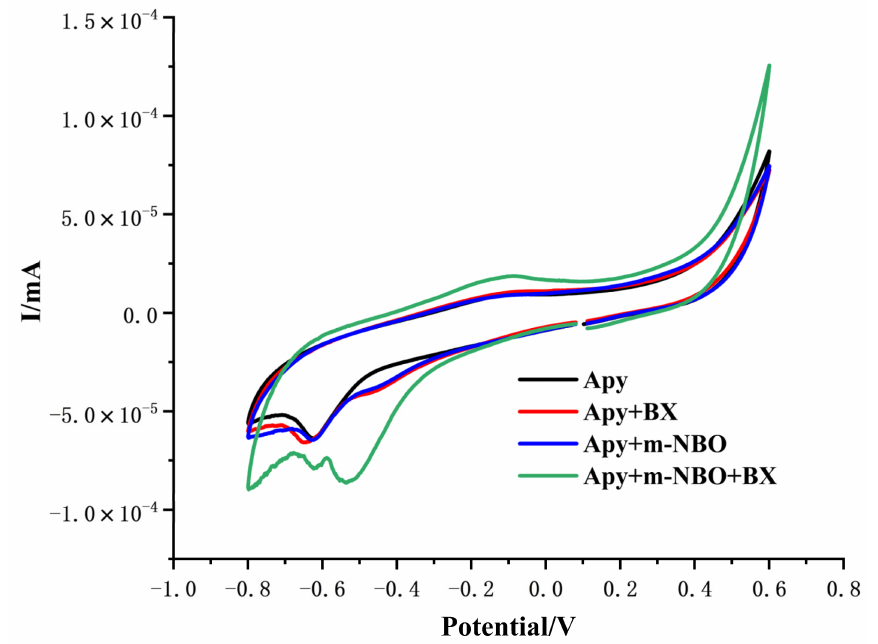
Figure 8. CV curves of the arsenopyrite electrode in the presence of m-NBO and NaBX at pH = 9;